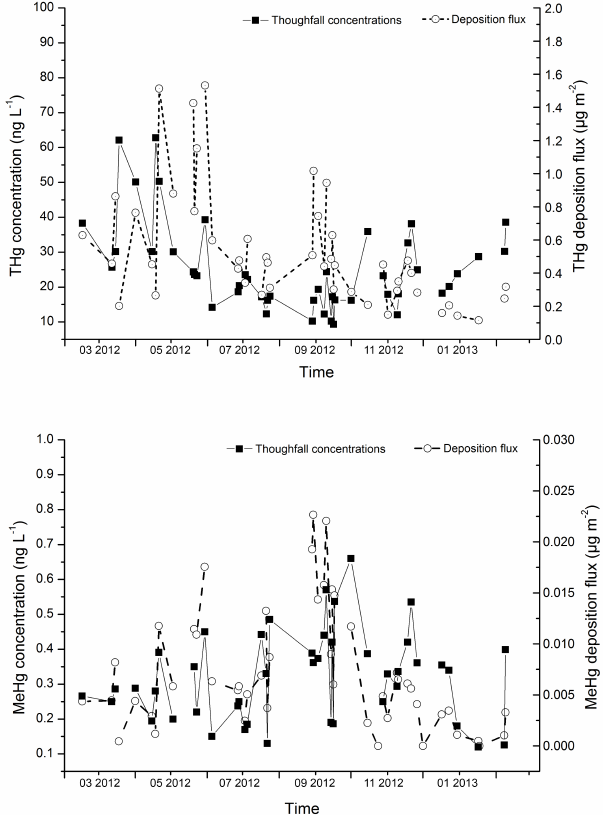
Figure 1. Volume-weighted mean concentrations of THg and MeHg and deposition fluxes of throughfall in the evergreen broad-leaf for- est from March 2012 to February